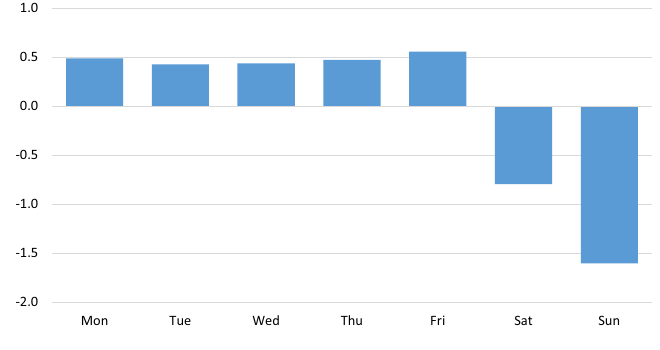
Fig. 5 Mean profile of the weekly